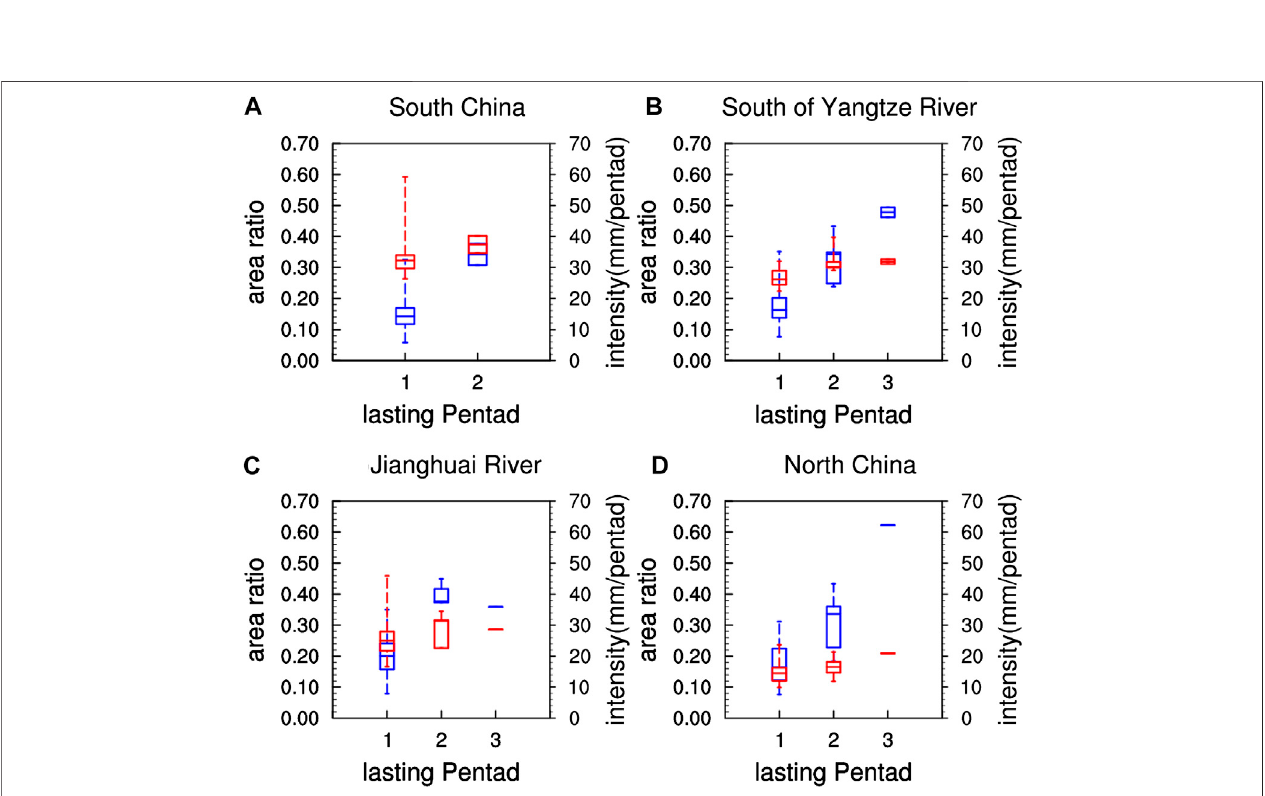
FIGURE 6 | Box-whisker plot for area ratio and intensity (unit: mm per pentad) against lasting pentad of RPEP in SC (A) , SYR (B) , JHR, (C) and NC (D) . The blue and red box-whiskers indicate area ratio and intensity, respectively.